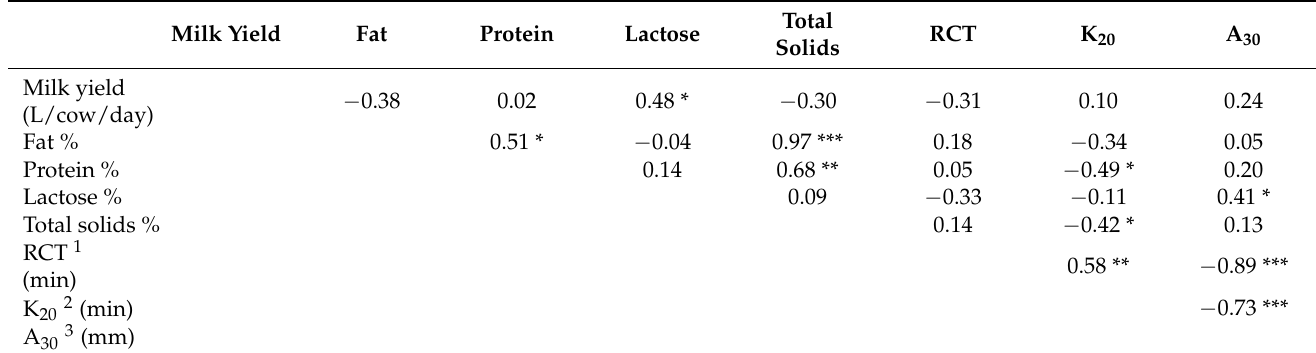
Table 5. Partial correlation coefficients between coagulation properties and milk components of cows milked once a day during the late lactation in the 2020–2021 production season.